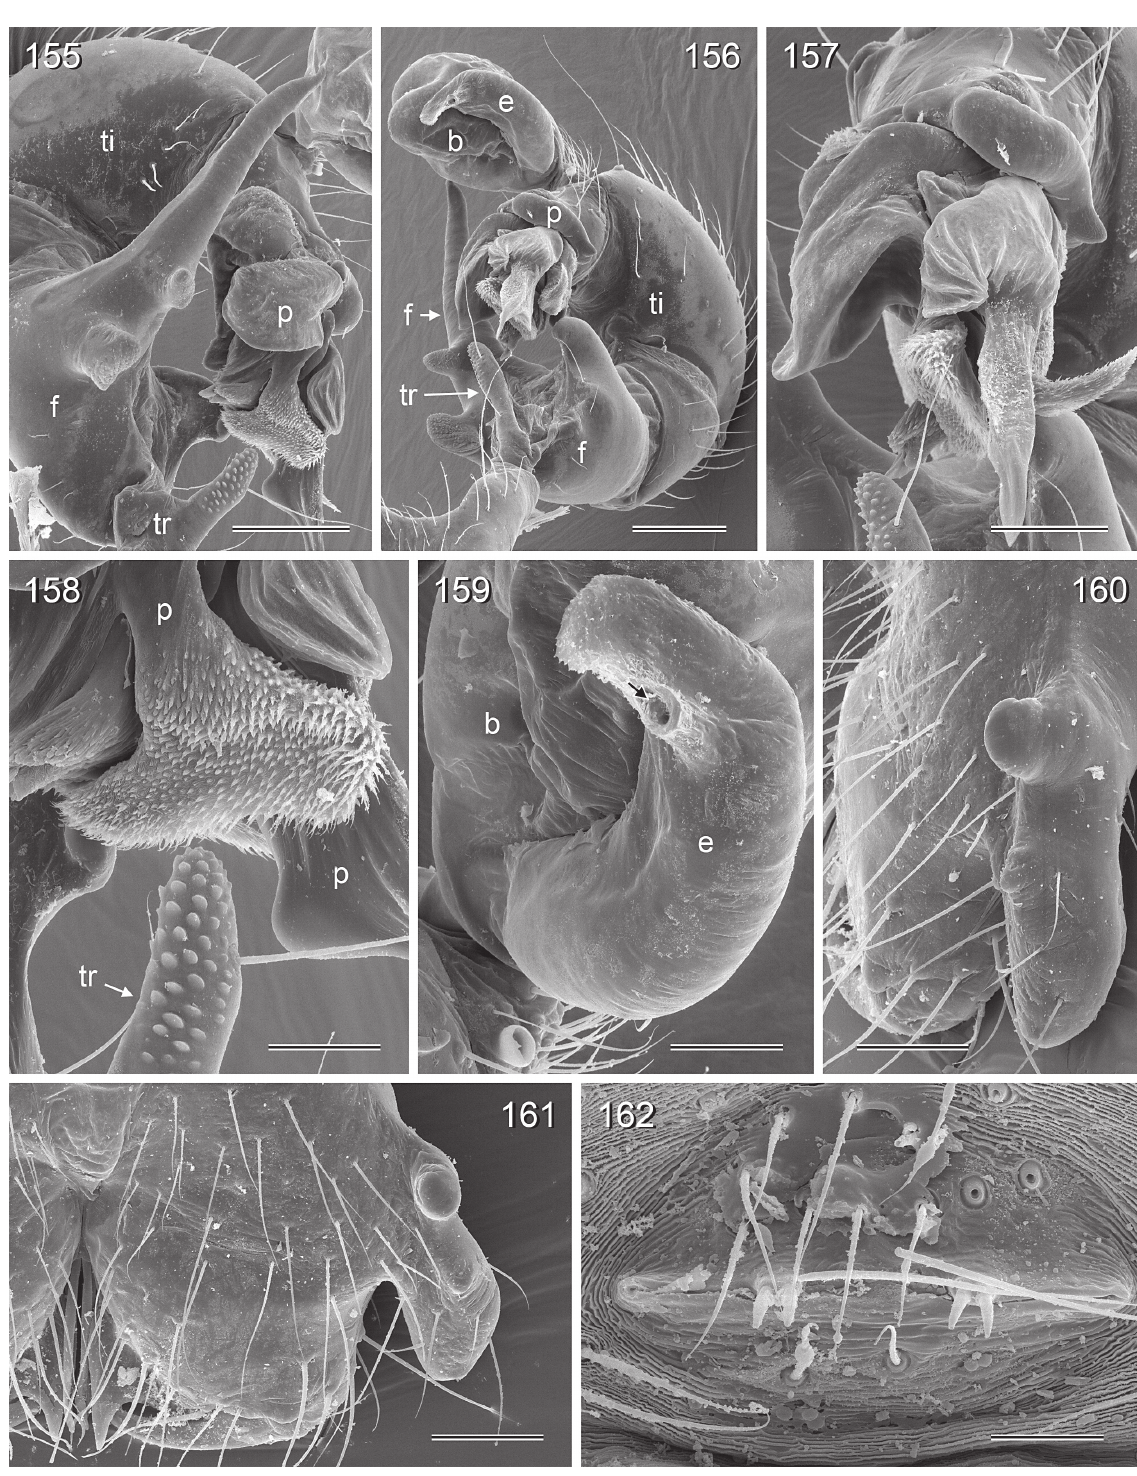
Figs 155–162. Aetana indah Huber, sp. nov. 155–156 . Left palp, prolatero-distal and retrolatero- distal views. 157 . Left procursus, retrolatero-distal view. 158 . Detail of left procursus (and trochanter apophysis), prolateral view. 159 . Left embolus (arrow points at sperm duct opening). 160–161 . Left male cheliceral apophyses, oblique frontal and frontal views. 162 . Male gonopore. b = genital bulb; e = embolus; f = femur; p = procursus; ti = tibia; tr = trochanter. Scale lines: 155–156 = 200 µm; 157 = 100 µm; 158–160 = 60 µm; 161 = 80 µm; 162 =